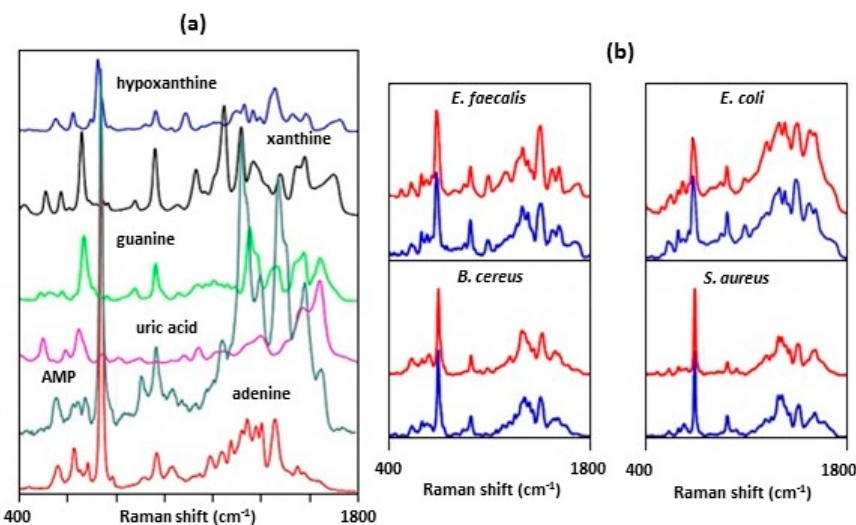
Figure 9. ( a ) SERS spectra of 20 μ M aqueous solutions of the indicated purine components of bacterial SERS spectra. The spectra have been offset for viewing and are normalized to the maximum peak intensity of the 20 μ M adenine solution [57]. ( b ) Comparison of the SERS spectra of cells (blue) for four bacterial strains and their corresponding enriched supernatant (red) [57]. Spectra of cells and supernatant are offset for better viewing. Spectra were obtained using 785 nm excitation. Reproduced with permission from Springer.